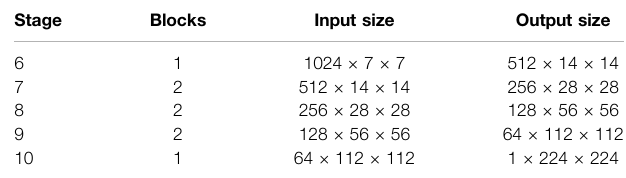
TABLE2| Parameters ofeachstageofthedecoder.Theinputsizeofthedecoder is the output size of the encoder, and the fi nal output size of the model is 1 × 224 ×